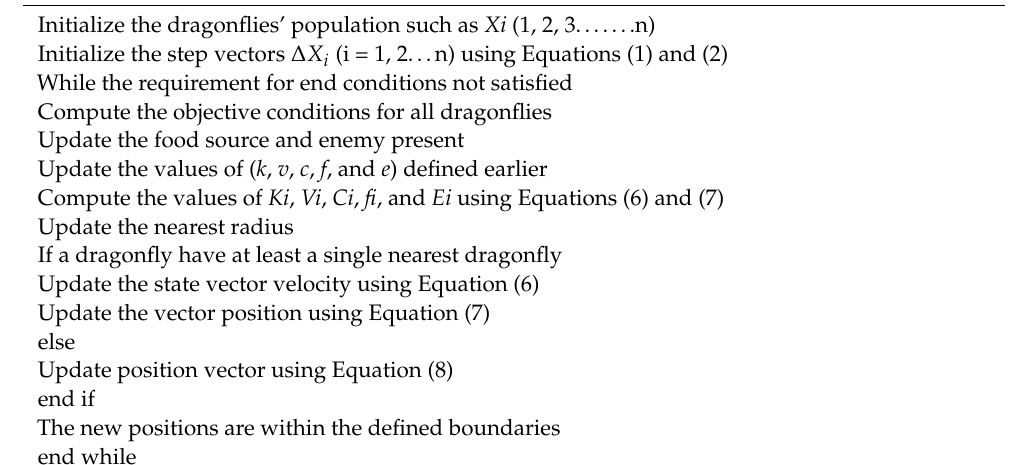
Algorithm 1. Application of dragonfly to determine the optimal size of the distributed energy resources.